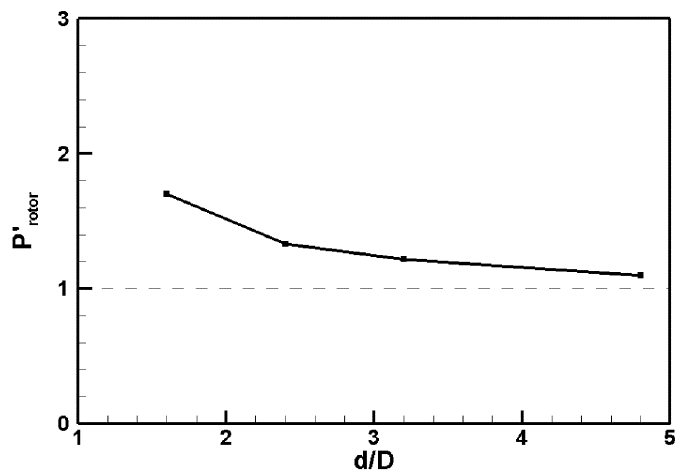
Figure 12. Normalized time-averaged power output for a pair of counter rotating rotors at various pair spacing. Please note that P ’ rotor = P rotor / P isolated_rotor and is evaluated on the per rotor basis.